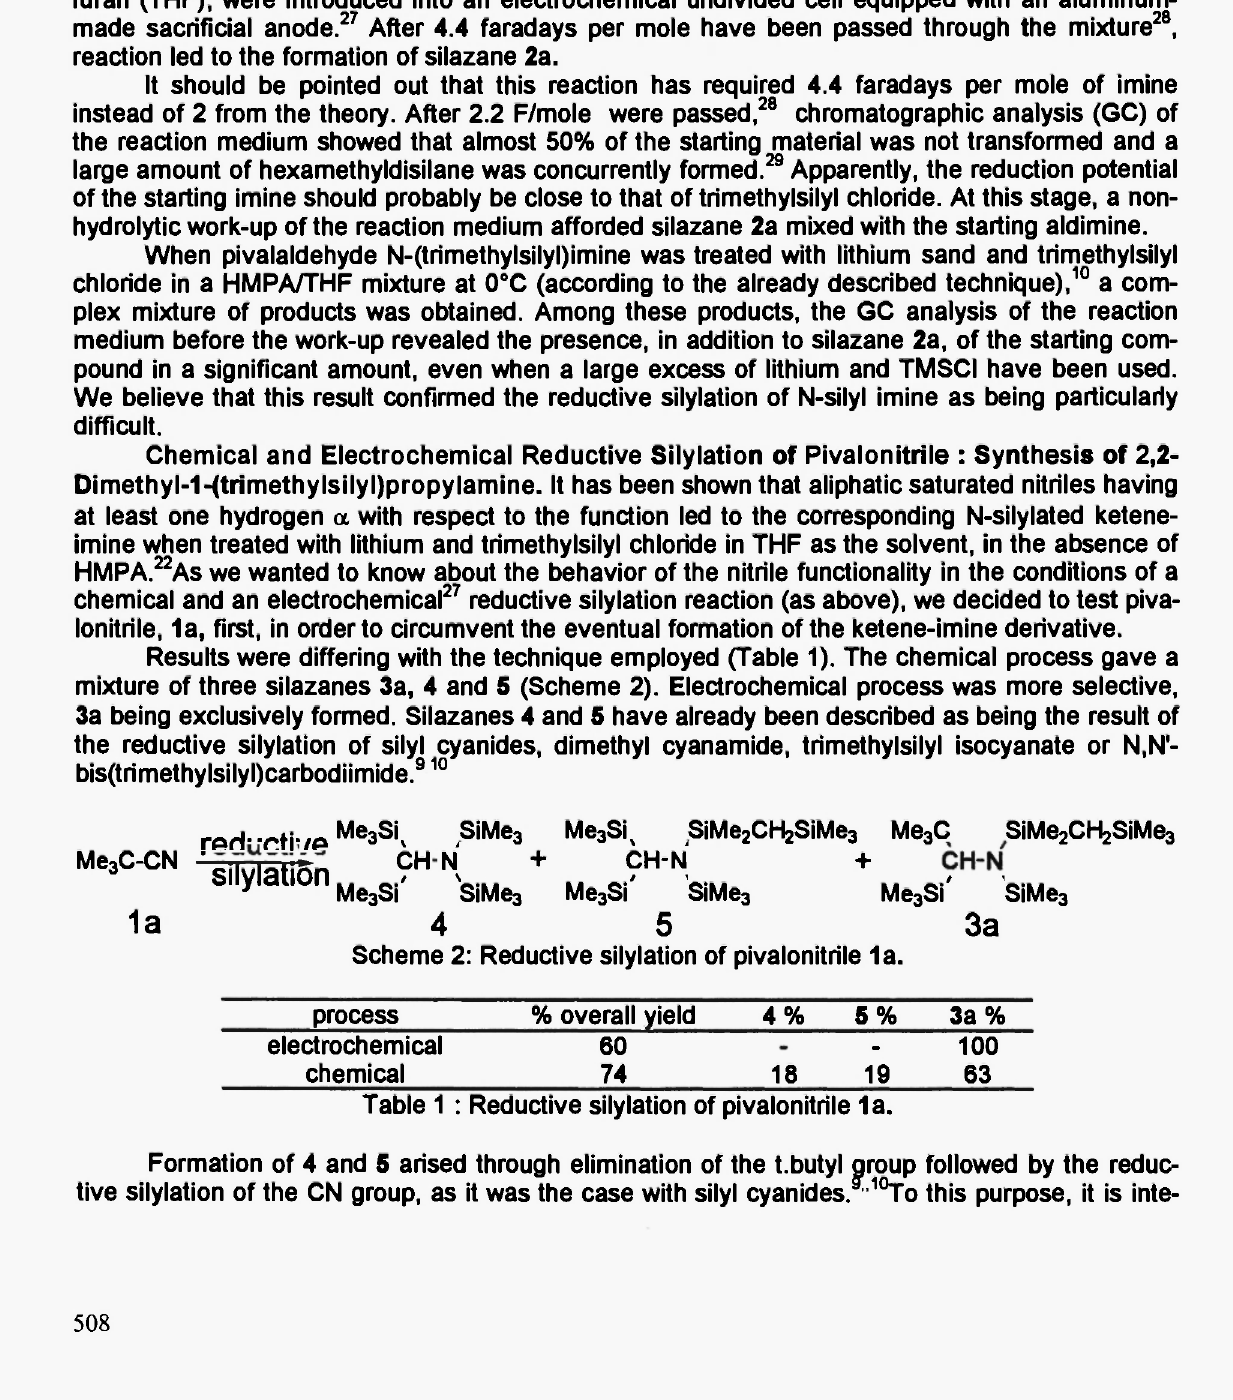
Table 1 : Reductive silylation of pivalonitrile